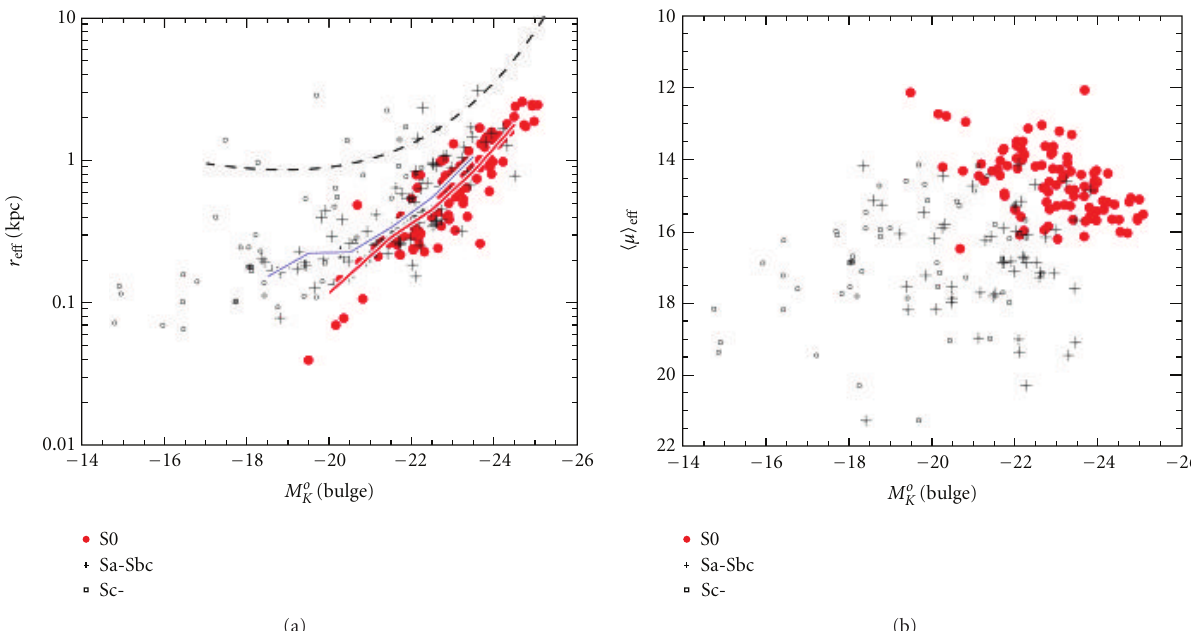
Figure 9: E ff ective radius (a) and e ff ective surface brightness (b) of bulges of S0 (red points), early-type (crosses), and late-type (squares) spirals as a function of the bulge absolute magnitude. The dashed line in the left panel corresponds to the relation followed by ellipticals galaxies from the Coma cluster. The continuous lines in the left panel correspond to the mean values of the data points in one- magnitude bins: S0s (red line) and Sa-Sbc (blue line). Credit: Laurikainen et al. [21]. Reproduced by permision from WILEY.